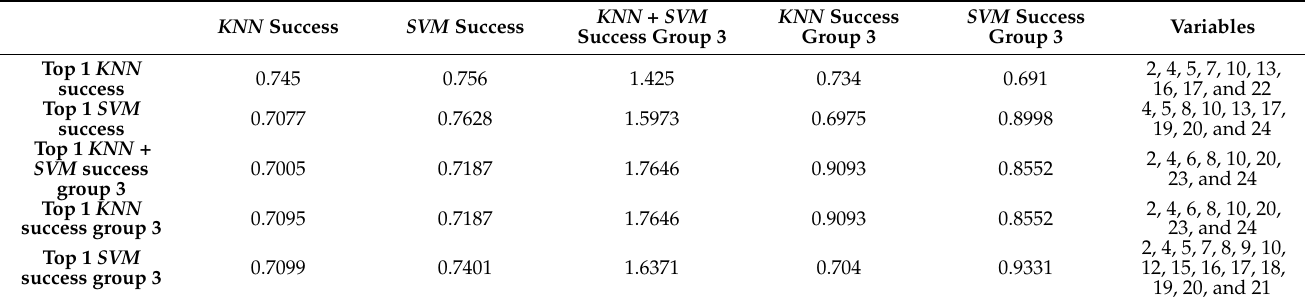
Table 1. Relationship between success in classification and variables